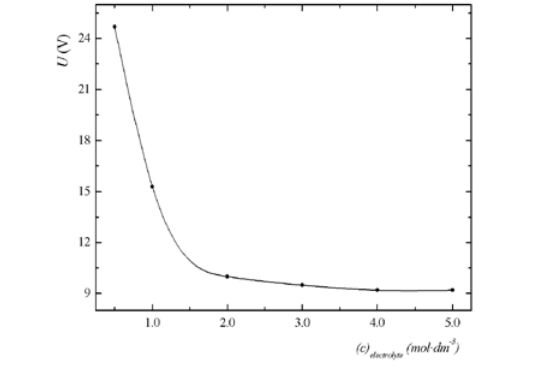
Figure 4. The dependence of absorption signal on the generation Figure 5. The dependence of the applied electric voltage on current for cell B : c = 1 mol dm -3 , v = 10 mL min -1 , el Ar electrolyte concentration for cell D : I = 0.3 v = 2.5 mL min -1 , c = 60 μg dm -3 . el Se